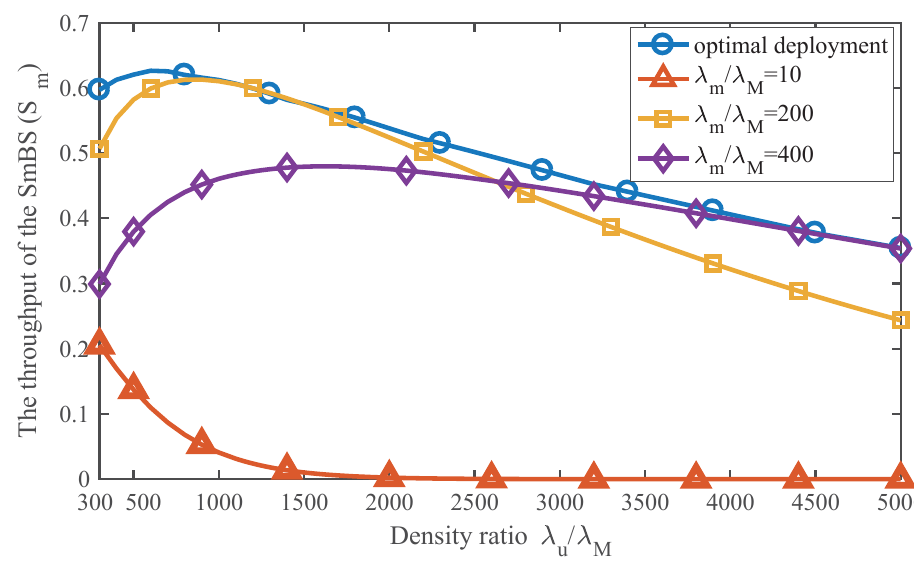
Figure 10. Effect of the optimal deployment on the throughput of an SmBS. P m / P M =